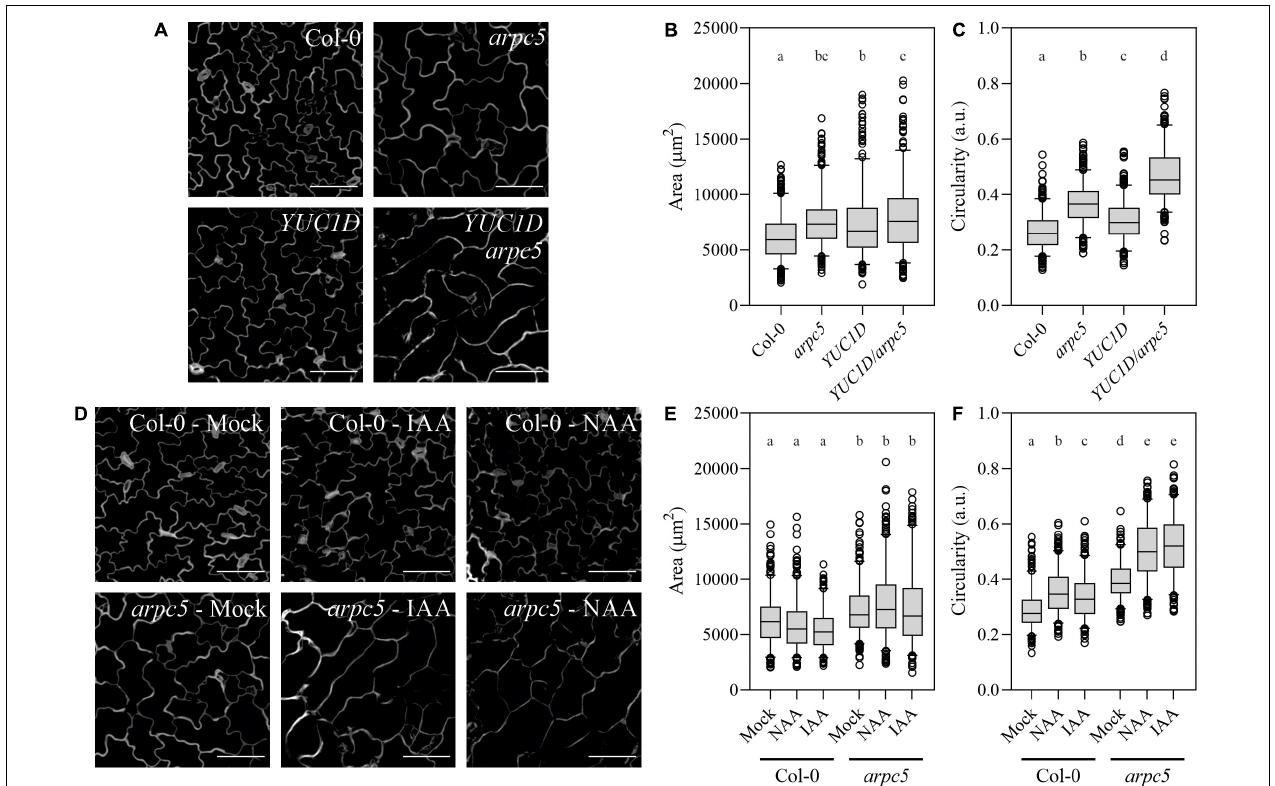
FIGURE 3 | Pavement cells morphology upon increased auxin levels. (A–C) The effect of increased endogenous auxin level in YUC1D plants crossed with arpc5. Representative pictures (A) and quantitative cell shape analysis (B,C) of five-day-old Col-0, arpc5 , and YUC1D, YUC1D/arpc5 epidermal lobed cells is shown. (D–F) The shape phenotype observed in YUC1D and YUC1D/arpc5 could be mimicked by 48 h treatment with 5 µ M auxin (IAA and NAA) of three-day-old Col-0 and arpc5 seedlings. Illustrative pictures are shown in (D) , quantitative cell shape analysis is depicted in (E) and (F) . Scale bar = 100 µ m. n = 250–350 cells, three biological replicates (Tukey HSD, p < 0.001; p < 0.05 for the area comparison between YUC1D and YUC1D/arpc5